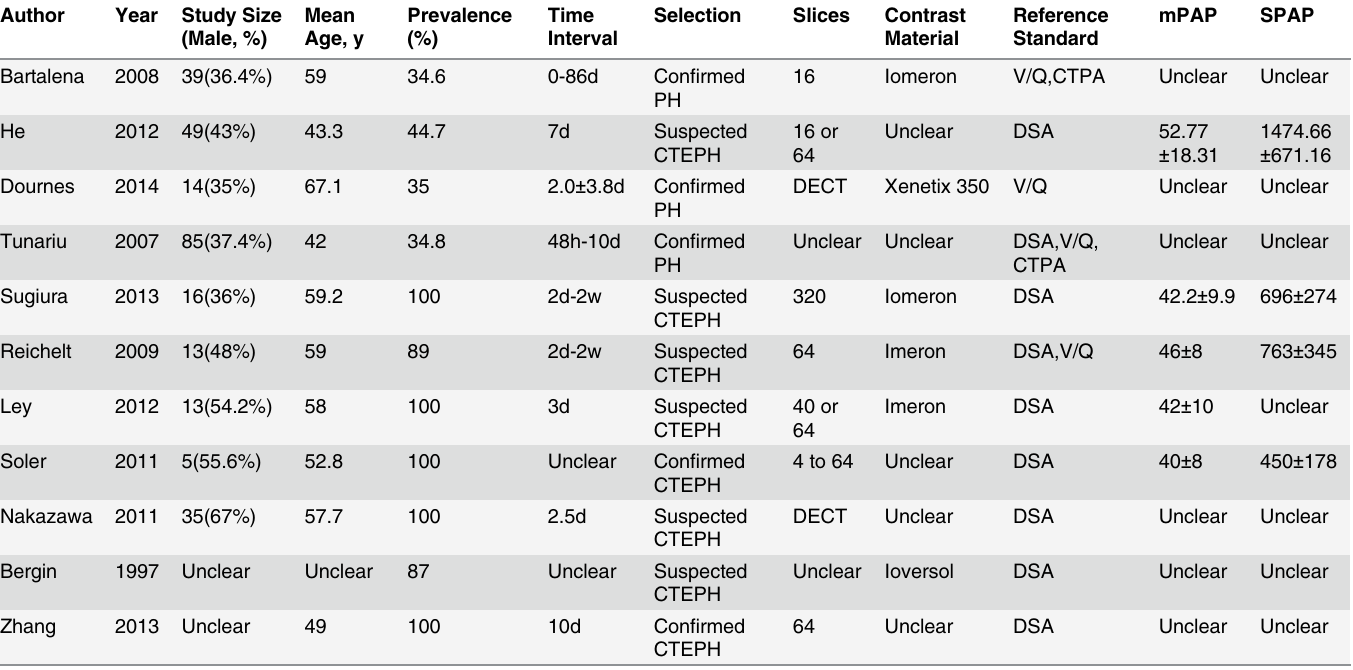
Table 1. Characteristics of included studies 1 .